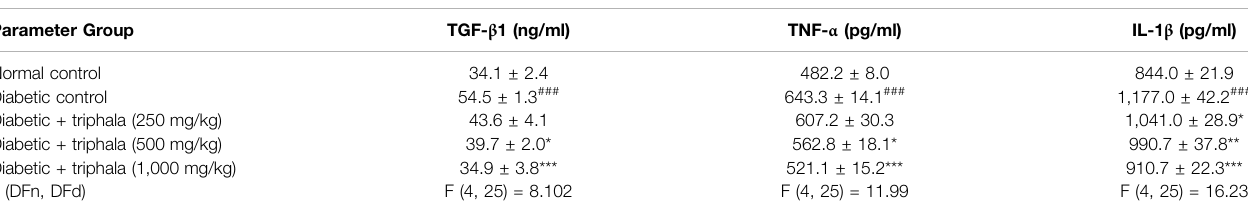
TABLE 2 | Effect of Triphala churna on in fl ammatory markers in diabetic neuropathy. Parameter Group Normal